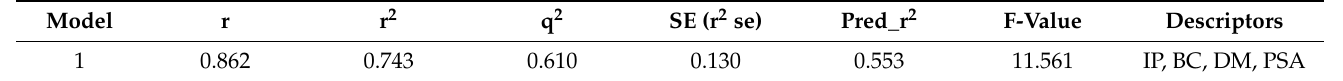
Table 3. Parameters value for the best 2D QSAR model